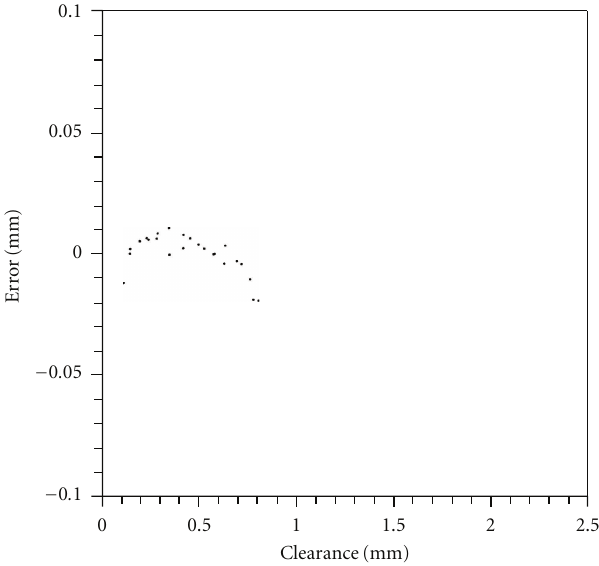
Figure 18: Error in FM capacitance probe measurement over the twenty four blades around the spinning rig wheel calculated by subtracting the known clearance between probe and blade tip from that calculated from the capacitance probe calibration. The calibration was obtained without datuming the capacitance